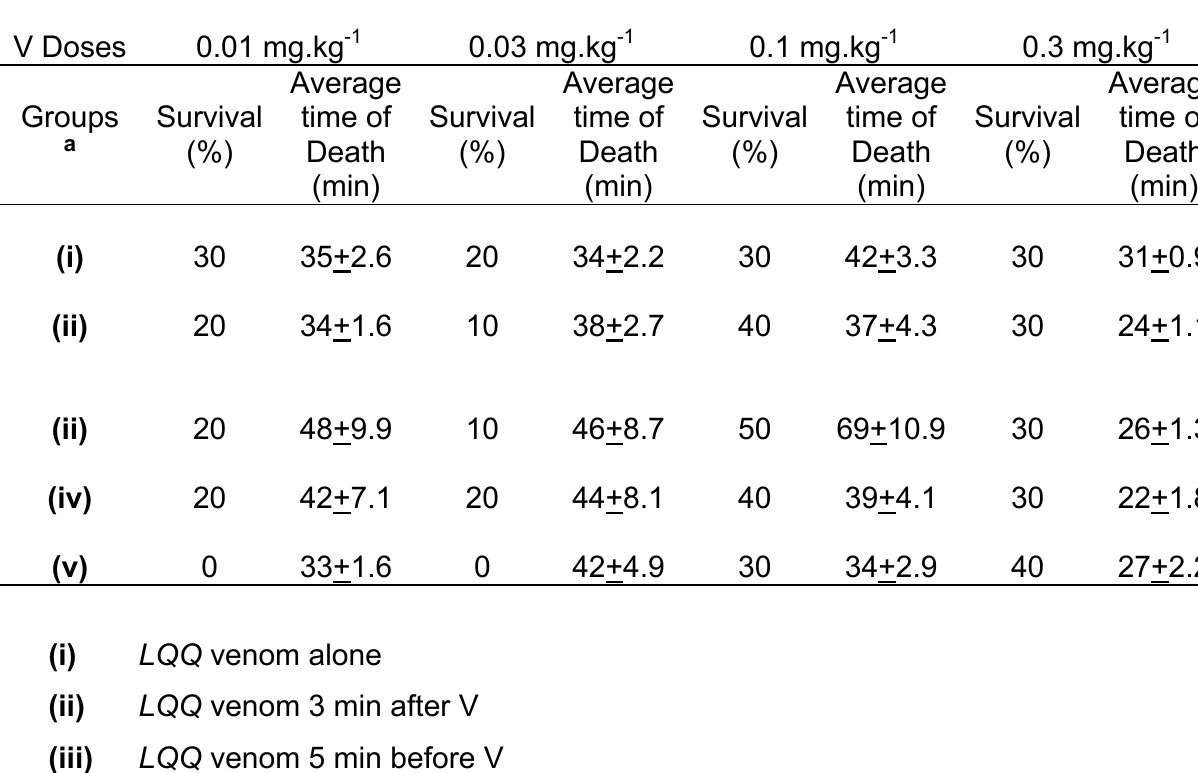
Table 5: Percent survival and average time of death of mice intravenously injected with verapamil (V) at different times before and after LQQ venom (250 (cid:80) g.kg -1 ,